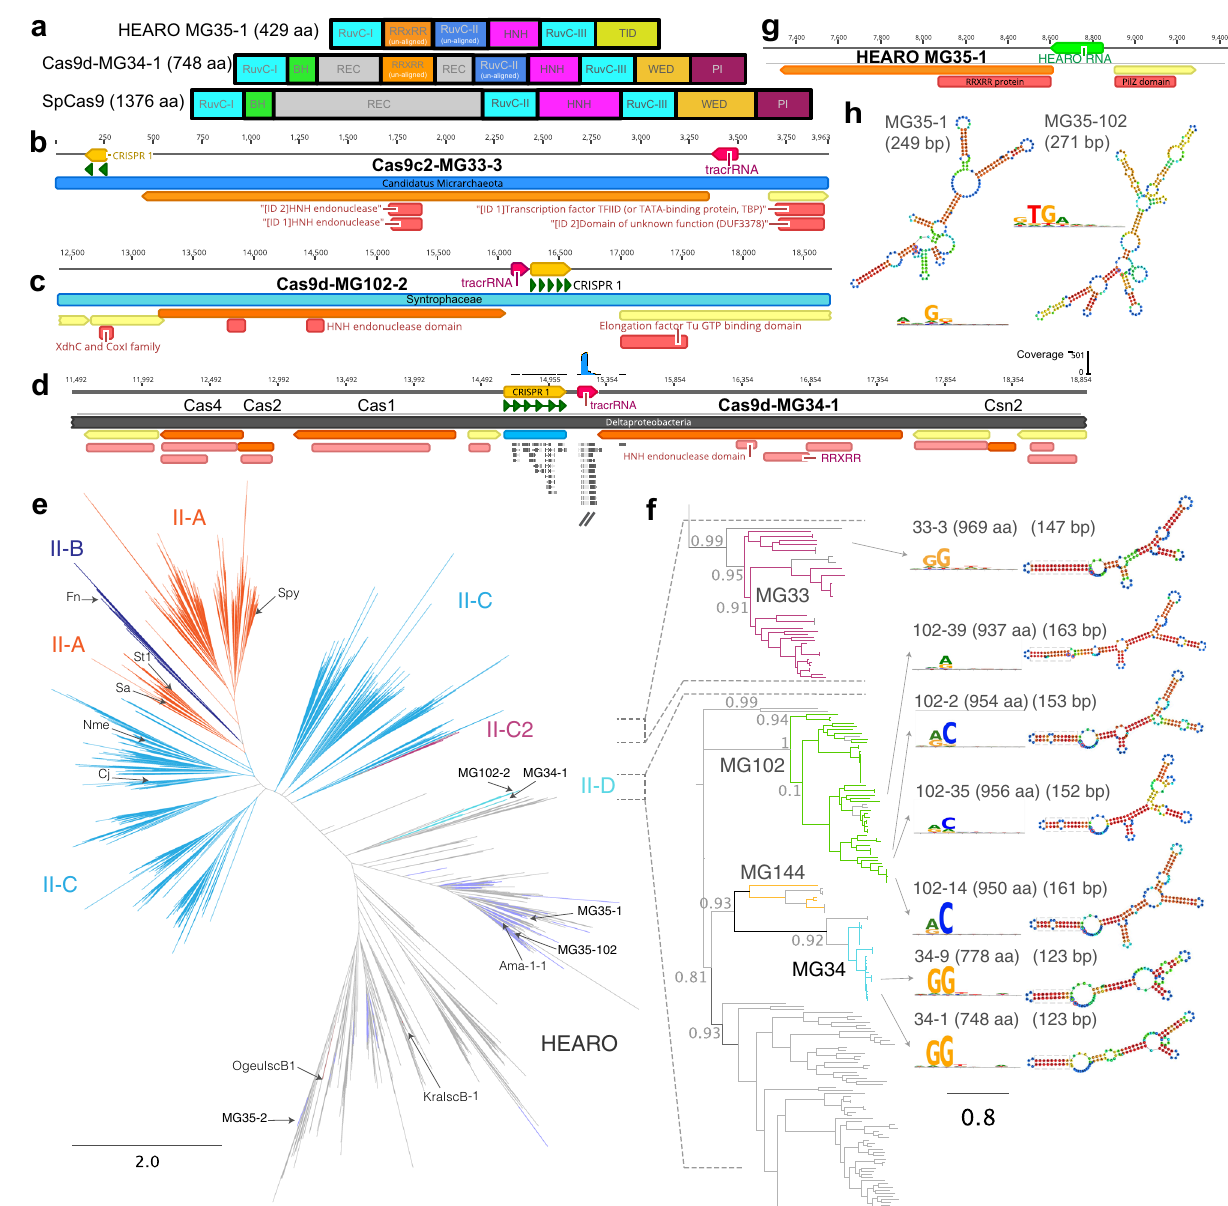
Fig. 1 | Cas9dand HEAROenzymes are dsDNA nucleaseswith diversetargeting ability.a PredicteddomainarchitectureofCas9dandHEAROnucleasesrecovered here vs. SpCas9 (not to scale). b – d Genomic context of the CRISPR-associated systems Cas9c2-MG33-33 ( b ), Cas9d-MG102-2 ( c ), and Cas9d-MG34-1 ( d ). The tracrRNA and CRISPR array orientations were con fi rmed by in vitro cleavage activitywiththeeffector.Adaptationmodulegenes(Cas1,Cas2,Cas4,andputative Csn2)wereidenti fi edinafewcases.EnvironmentalRNASeqreadsin( d )mappedin the forward orientation to the array and intergenic region encoding a tracrRNA. Genes not associated with the described nucleases are represented by yellow arrows. e Phylogenetic protein tree of Cas9d, Cas9c2, and HEARO nucleases vs. reference sequences. The tree wasinferredfrom a multiplesequencealignment of the shared RuvC-II/HNH/RuvC-III domains across >11,800 sequences. The Cas9c2- MG33 family of nucleases (burgundy branches) clusters with two archaeal Cas9 references, while other CRISPR-associated Cas9d (teal branches) cluster with